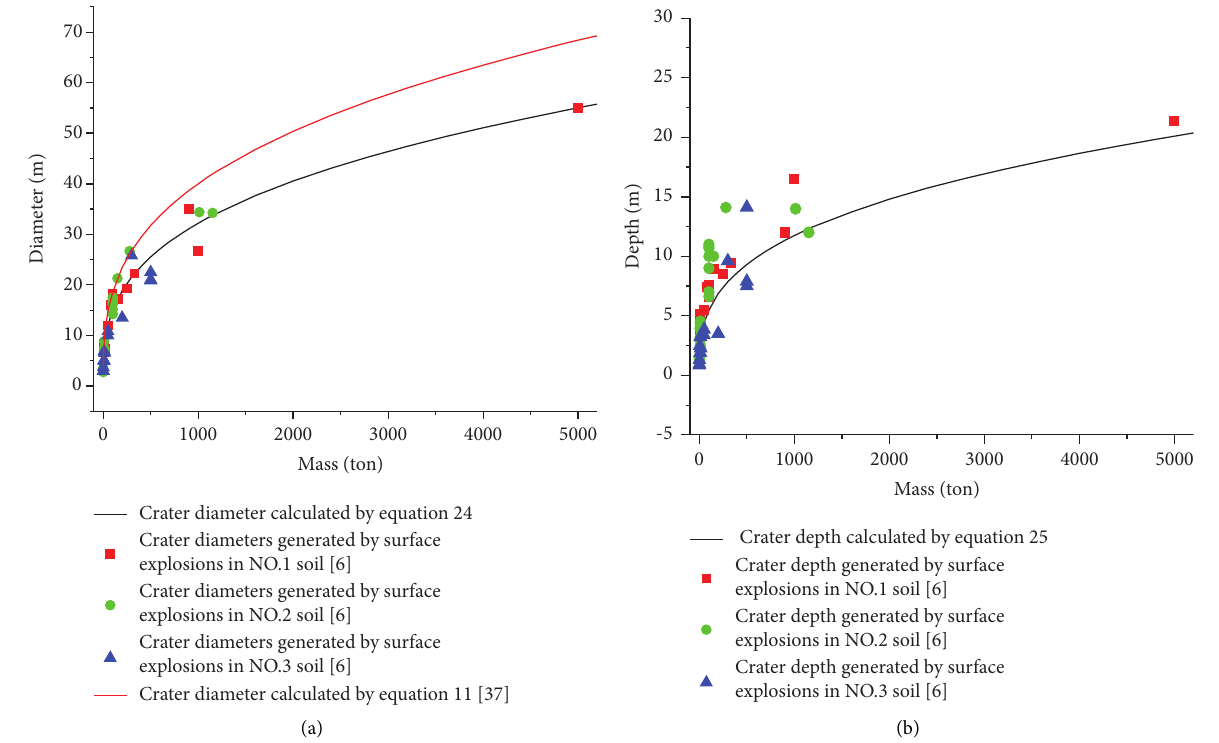
Figure 11: Comparison between the calculated crater dimensions and previous field test